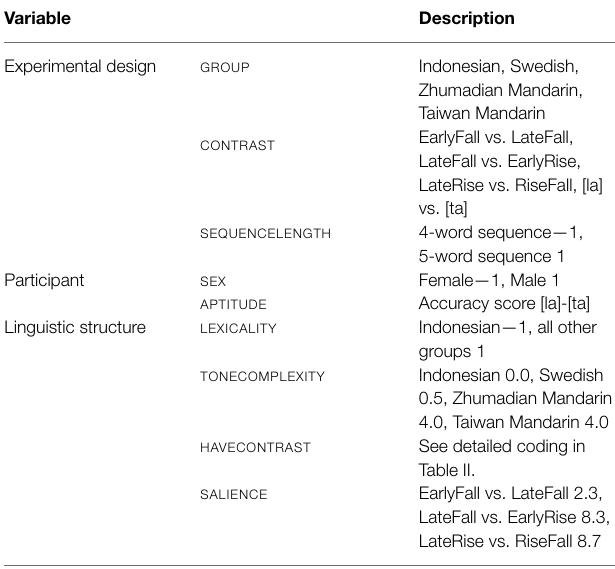
TABLE 3 | Independent variables in the investigation.